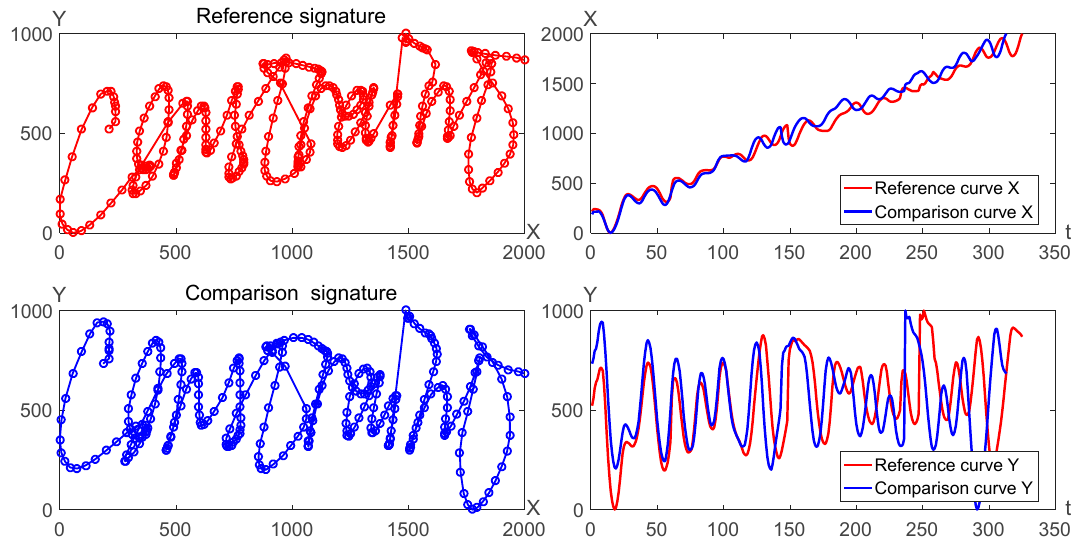
Figure 3. Two signature curves and their corresponding X and Y curves.